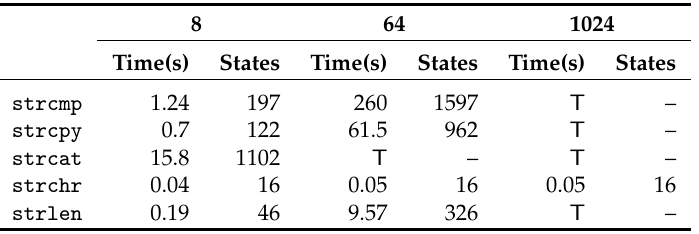
Table 3. Benchmark of standard library functions abstracted using only the M-String definitions of access and update operations for Sequence inputs of size 8, 64 and 1024 characters. Verification for Word strings times out in most of the instances.